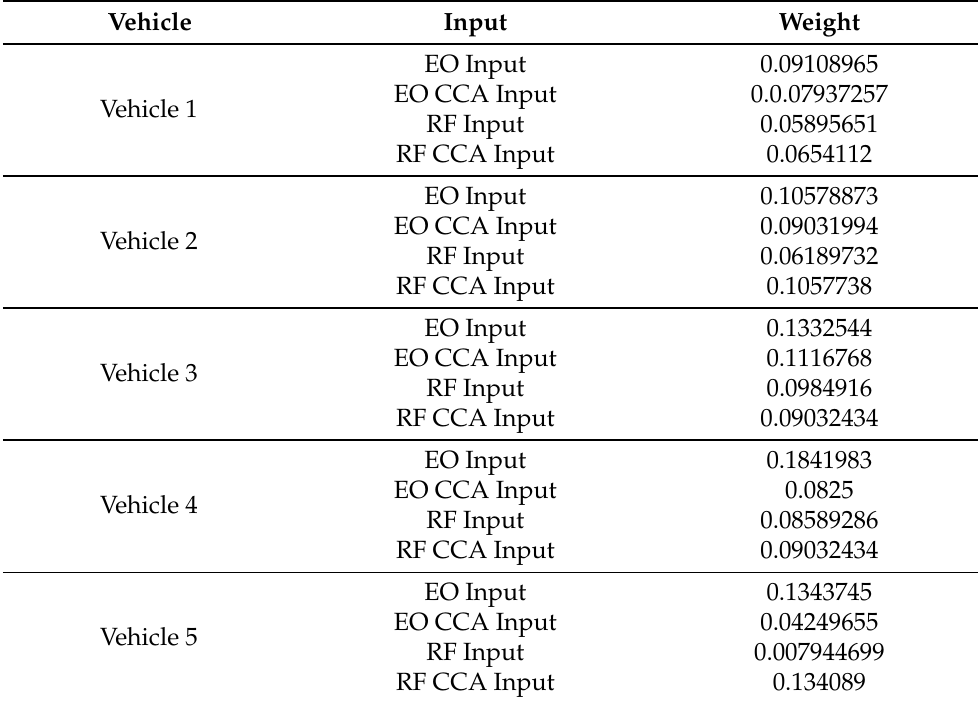
Table 4. explainX.ai weight results for Scenario